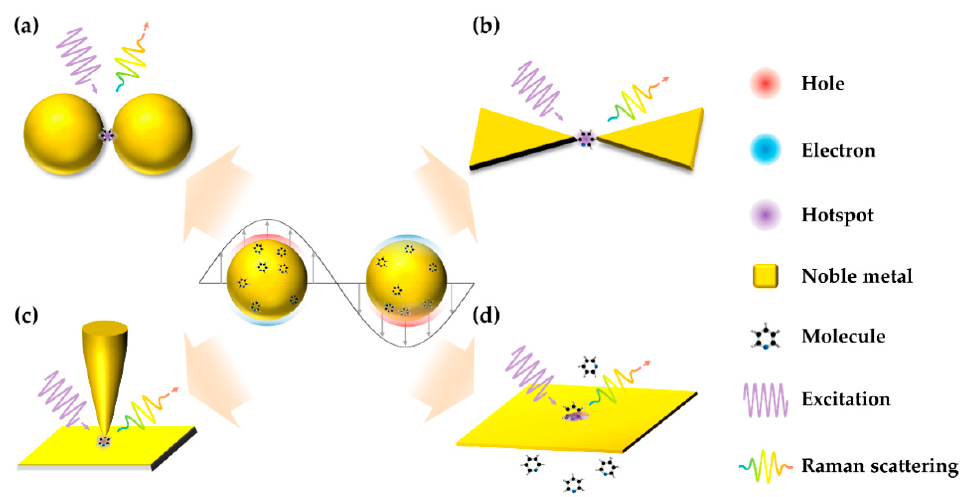
Figure 1. Schematic diagram of SM-SERS. Center: SPR effect of nanoparticles; Inset: ( a ) dimetric nanostructure; ( b ) plasmonic single-molecule junction; ( c ) plasmonic tip; ( d ) plasmonic nanopore.